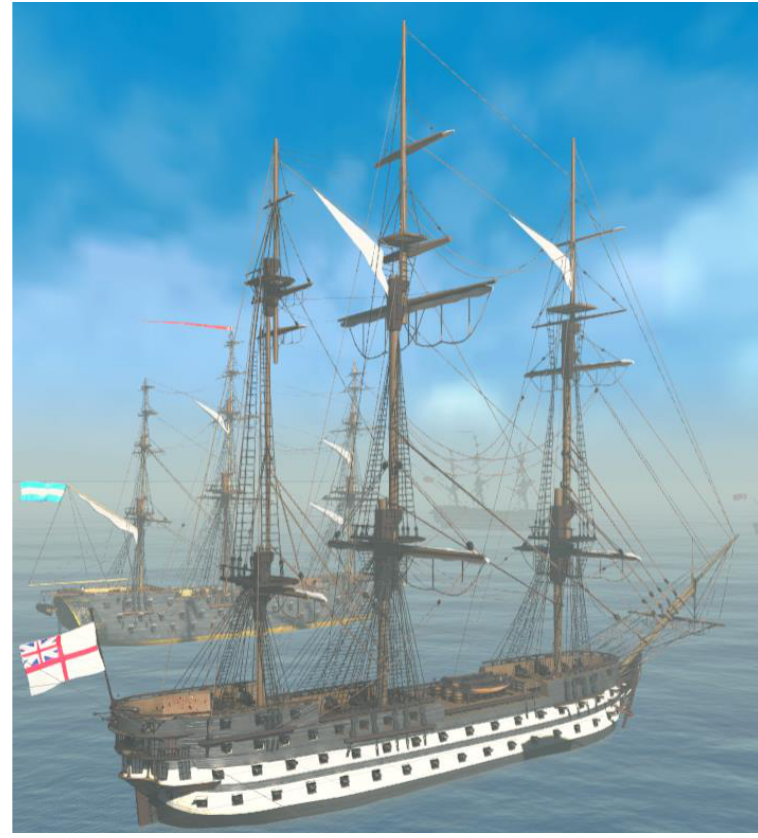
Figure 18 . The British “Asia”. Screenshot from Unity3d.